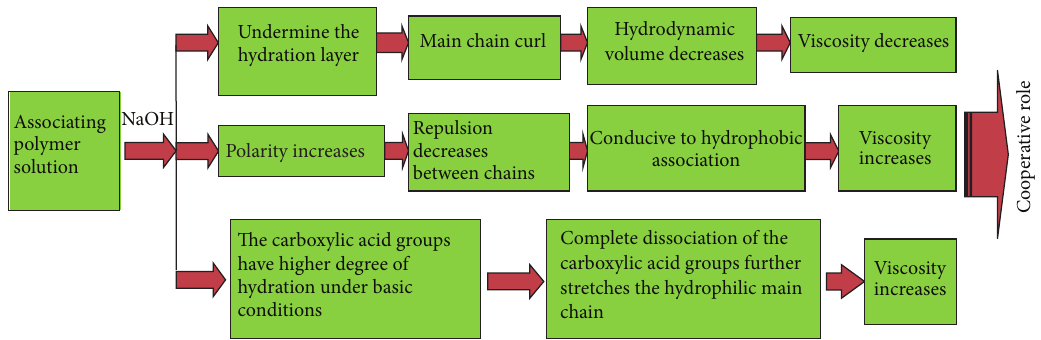
Figure 11: The effect of alkali on the viscosity of the associating polymer solution.